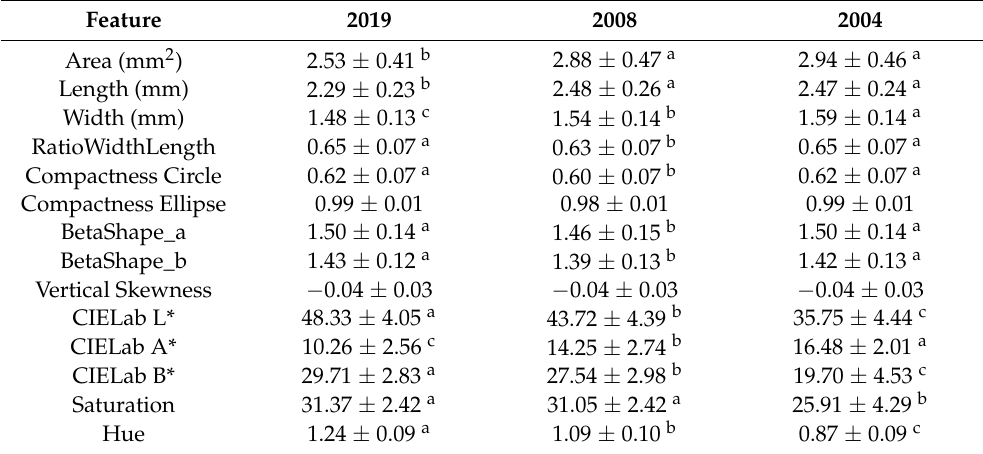
Table 2. Comparative analysis of morphological characteristics of alfalfa seeds in different harvest